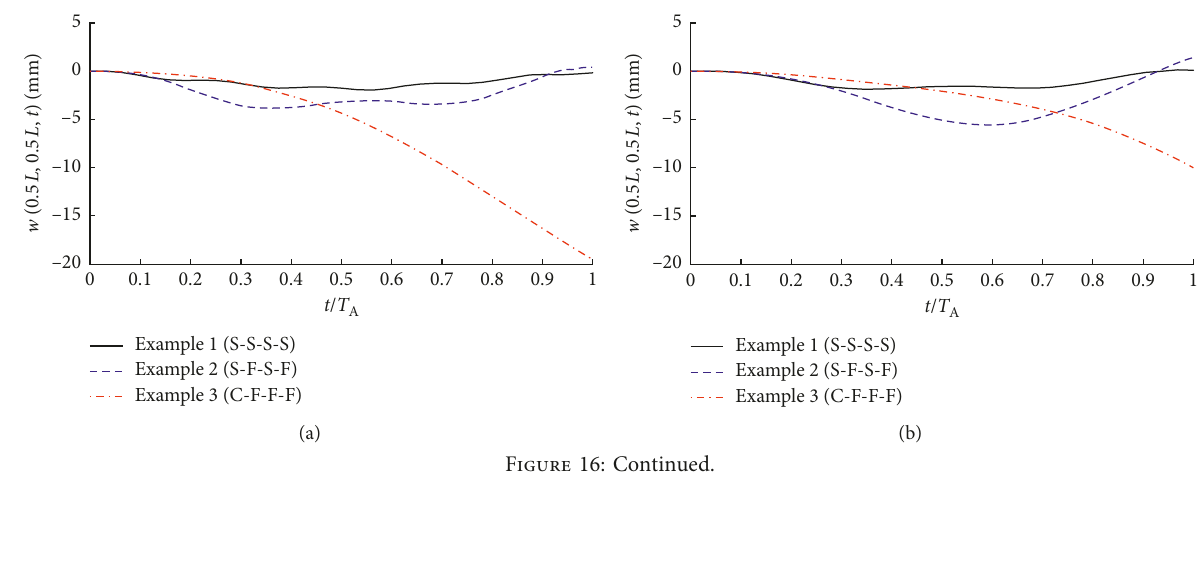
5 m/s. (a) At X 0.5 L , Y 0.5 L , (cid:31) (cid:31) (cid:31)